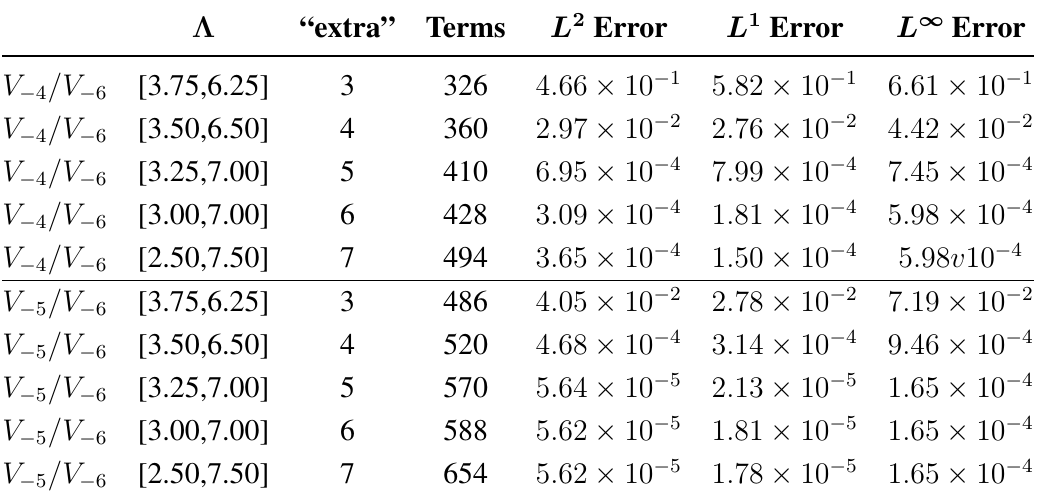
Table 2. Error from multi-scale linear Rossby wave results.